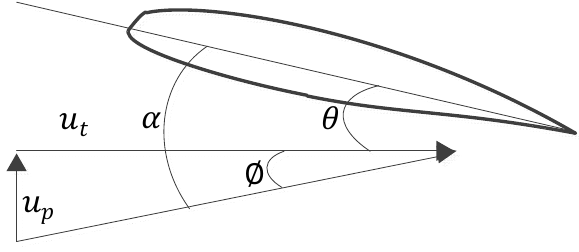
Figure 4. The flow angle of the blade airfoil.